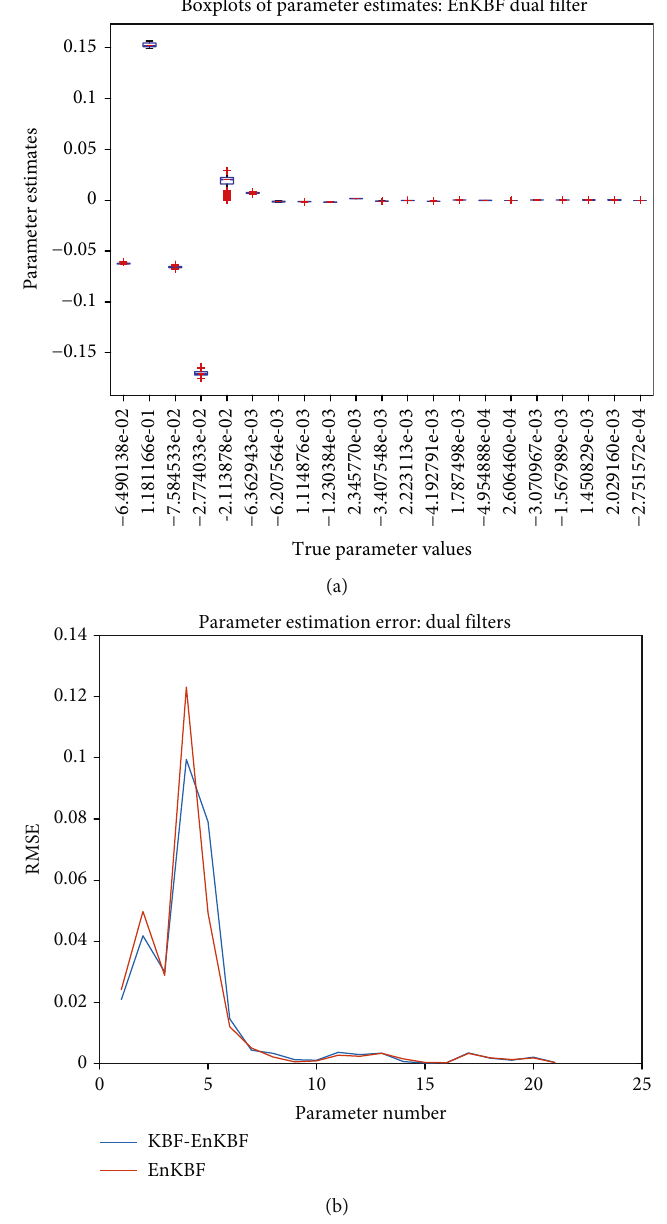
Figure 10: (a, b) are, respectively, the boxplots showing the distribution of the 21 hyperparameter estimates of the EnKBF dual fi lter after a burn-in of 500 iterations and plots of the root mean square error for the hyperparameter estimates obtained using KBF-EnKBF and EnKBF (with di ff erent ensemble sizes) dual fi lters, applied to the wave equation (Example